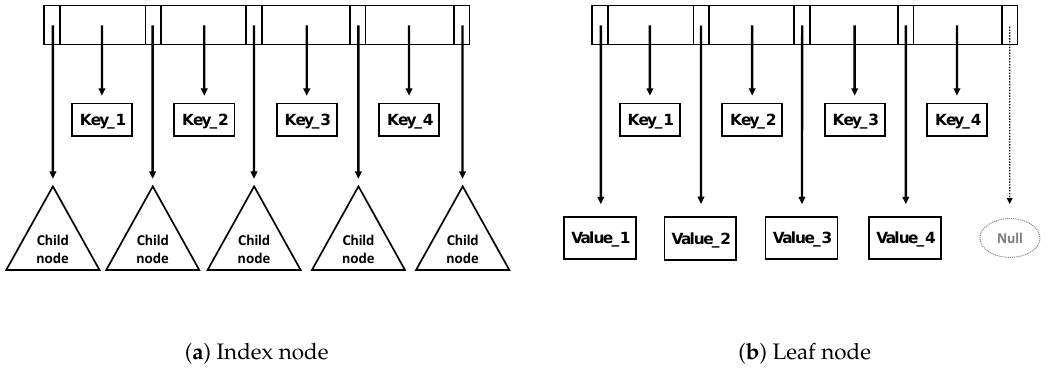
Figure 3. The layout of tree nodes in the B+ tree